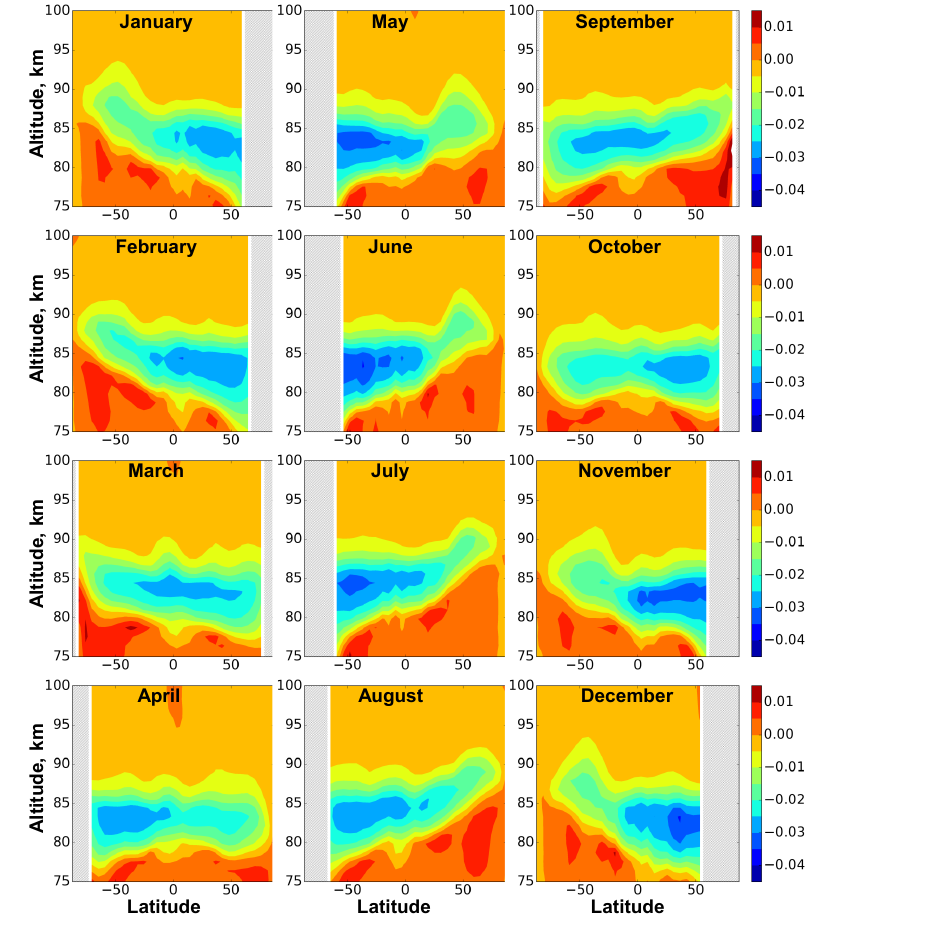
Figure 1. Daytime mean monthly averaged O 3 / O 3eq −